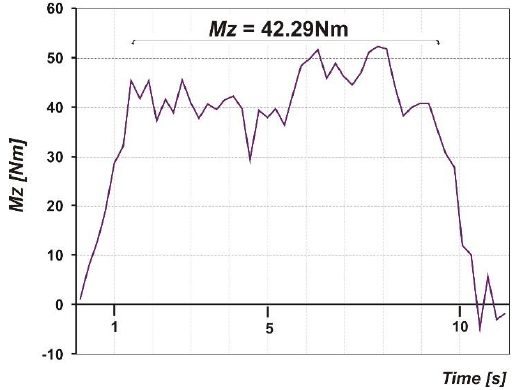
Figure 13. Sample course of the aligning moment, M Z .